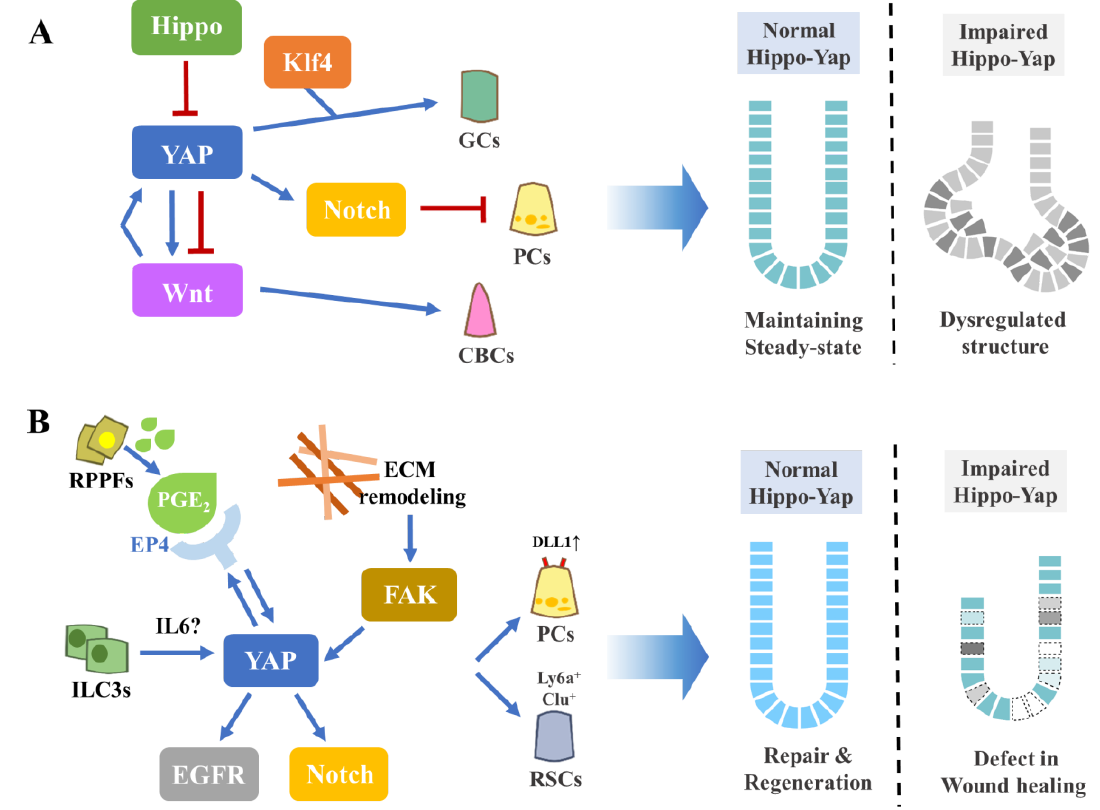
Figure 2. The Hippo – YAP signaling in intestinal homeostasis, regeneration, and tumorigenesis. ( A ) In the steady state, Hippo constantly suppresses the YAP signaling to maintain the crypt – villus integrity. ( B ) endogenous- and exogenous insults such as inflammation and irradiation induce PGE 2 signaling or ECM remodeling, which in turn activates YAP signaling and initiates the cellular reprogramming process for the regeneration.